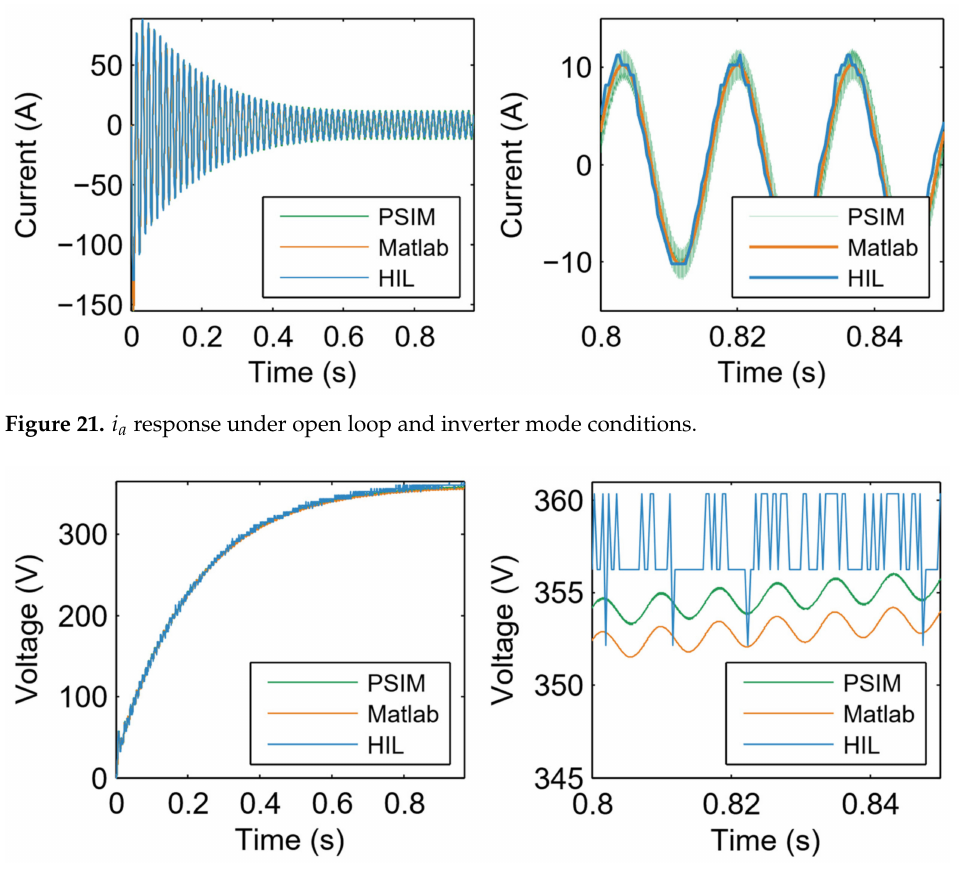
Figure 22. v dc response under open loop and inverter mode conditions.